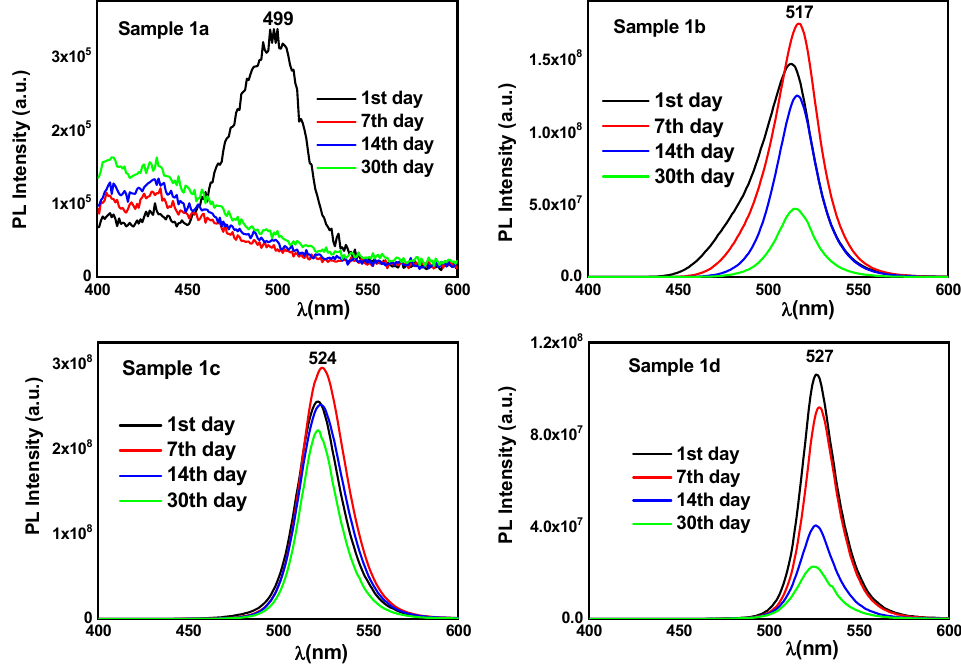
Figure 4. Fluorescence emission spectra of solutions ( 1a ), ( 1b ), ( 1c ), and ( 1d ) from 1st (black line), 7th (red line), 14th (blue line), and 30th (green line) day.